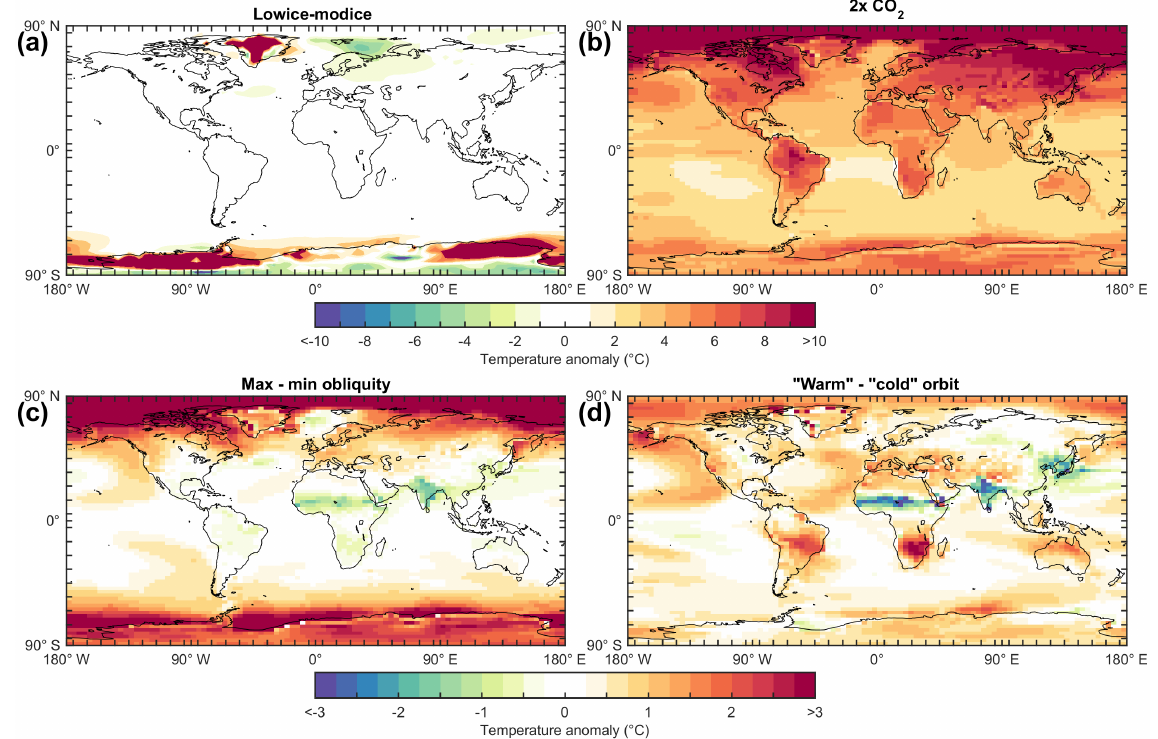
Figure 4. Mean annual SAT ( ◦ C) anomalies produced by the various climate forcings. (a) The lowice experiments compared with their modice equivalents, averaged across the five lowice experiments. (b) – (d) Idealised experiments performed using the modice emulator. All orbital and CO 2 conditions are set to pre-industrial values unless specified: (b) 2 × pre-industrial CO 2 , (c) maximum obliquity compared to minimum obliquity, (d) warm orbital conditions (high eccentricity, NH summer at perihelion) compared to cold orbital conditions (low eccentricity, NH summer at aphelion). The different forcings result in global mean SAT anomalies of (b) 4.2 ◦ C, (c) 0.4 ◦ C and (d) 0.4 ◦